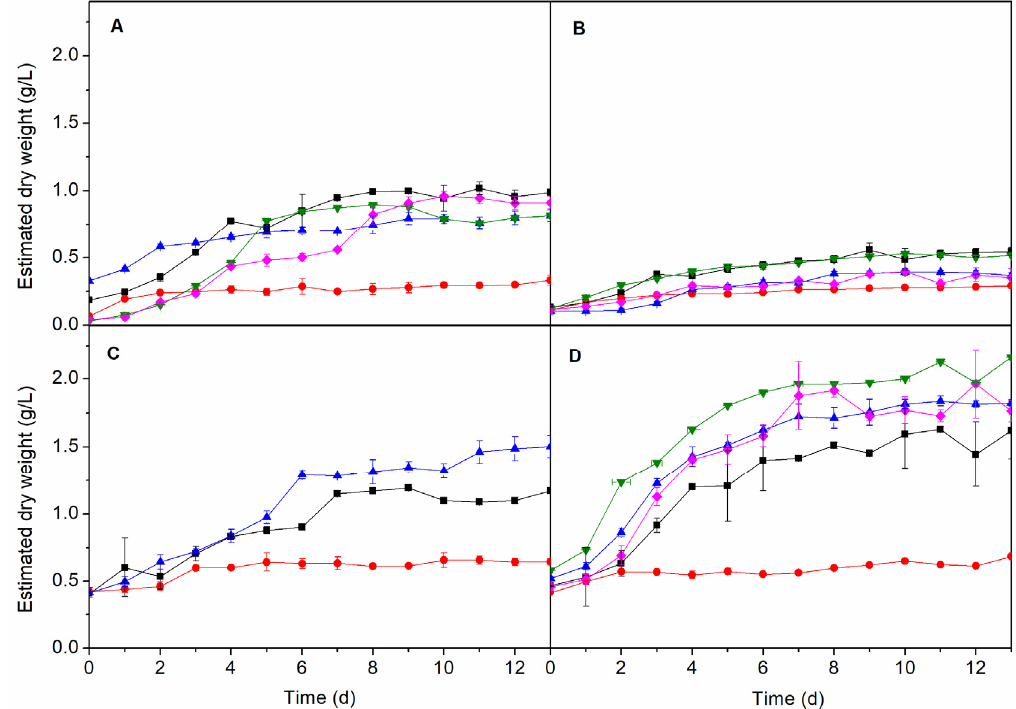
Figure 3. Growth of A. maxima ( A ), C. vulgaris ( B ), I. galbana ( C ) and N. gaditana ( D ) with different culture media ( ■ MC1, ● MC2, ▲ MC3, ▼ MC4 and ♦ MC5). Conditions for all cultivations: inoculum:culture medium ratio of 5:45 and a photoperiod of 12:12 h.